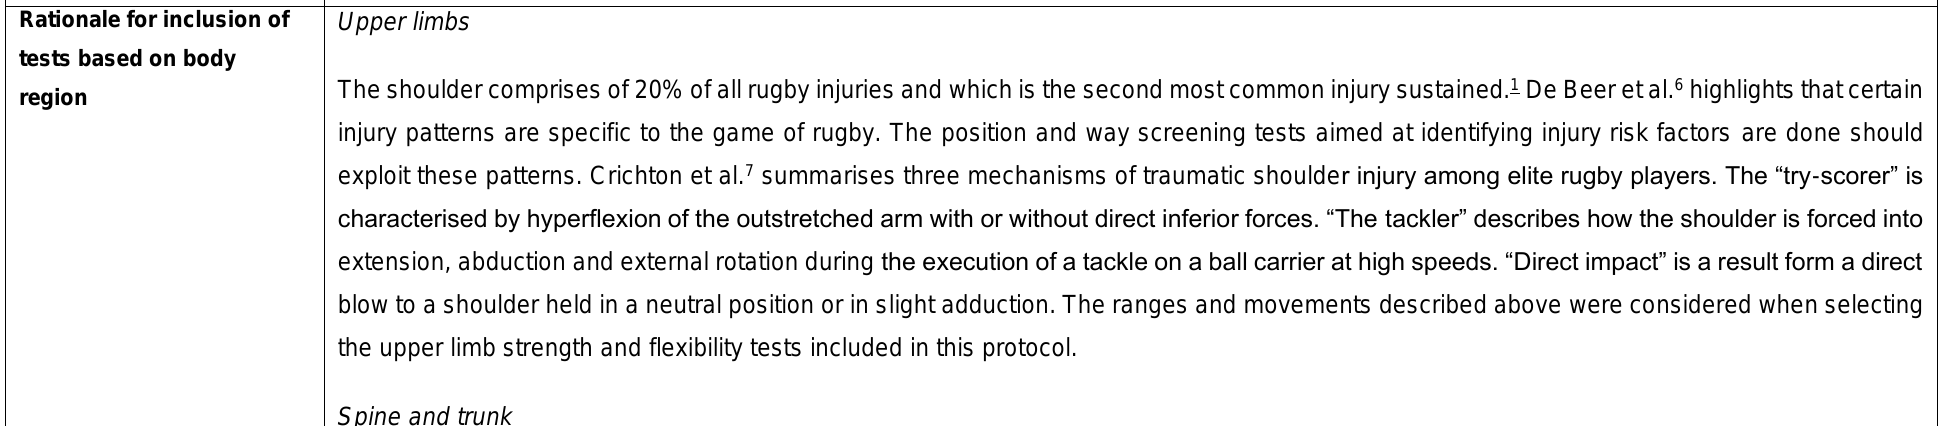
TABLE 2-A1: Purpose and Rationale for inclusion, modification and minimal standards for flexibility and strength tests included in the SSL® Screening protocol.